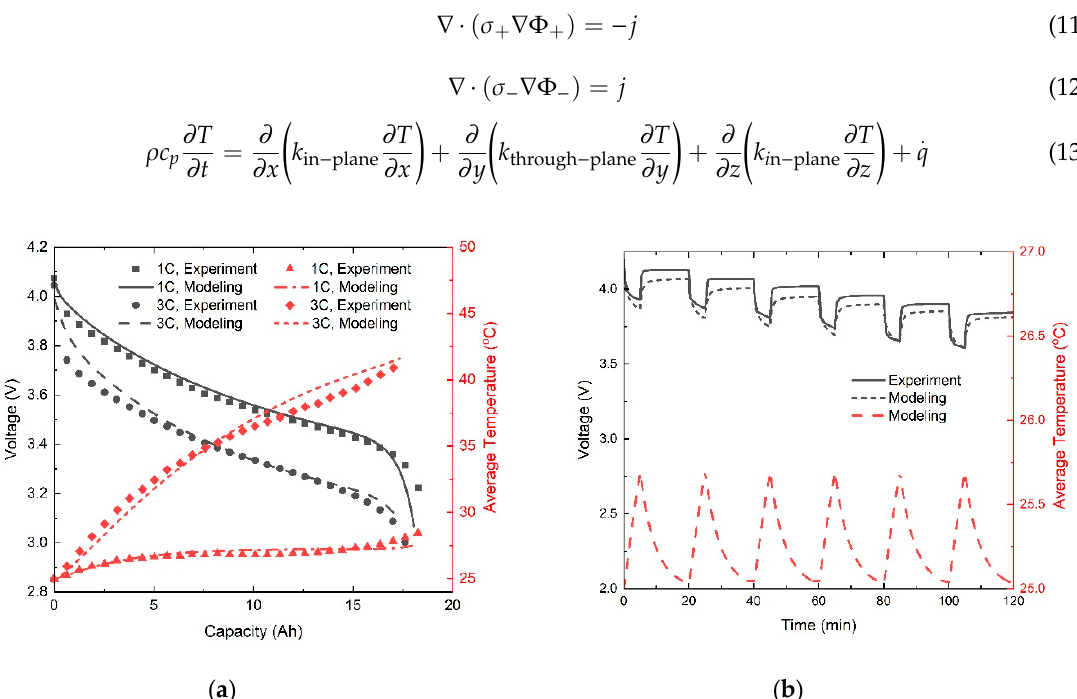
Figure 2. Model validation with experimental data. ( a ) Constant current discharging; ( b ) pulse waveform current discharging. Table 1. Physical properties for the lithium-ion battery cell.